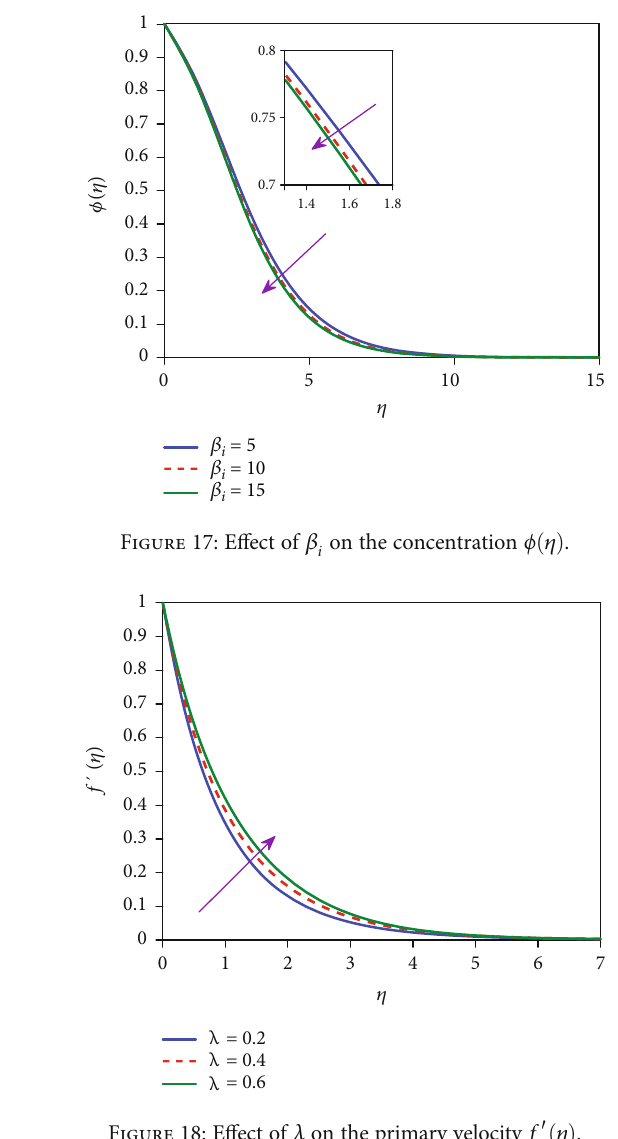
Figure 16: E ff ect of β on the temperature θ ð η Þ . i